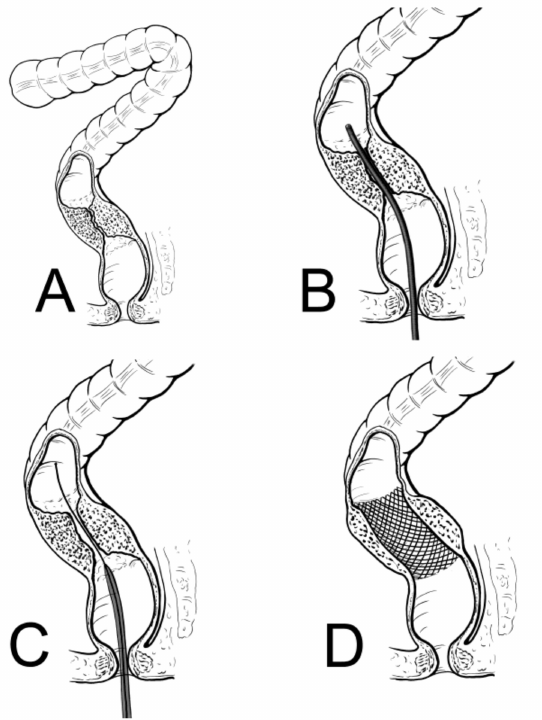
Figure 1. SEMS placement is showed. ( A , B ) A thin nasogastroscope is used to pass the obstruc- tion under direct vision to avoid complications (perforation). ( C ) Through the nasogastroscope a guidewire and the stent are placed through the obstruction. ( D ) Appropriate placement of the stent.